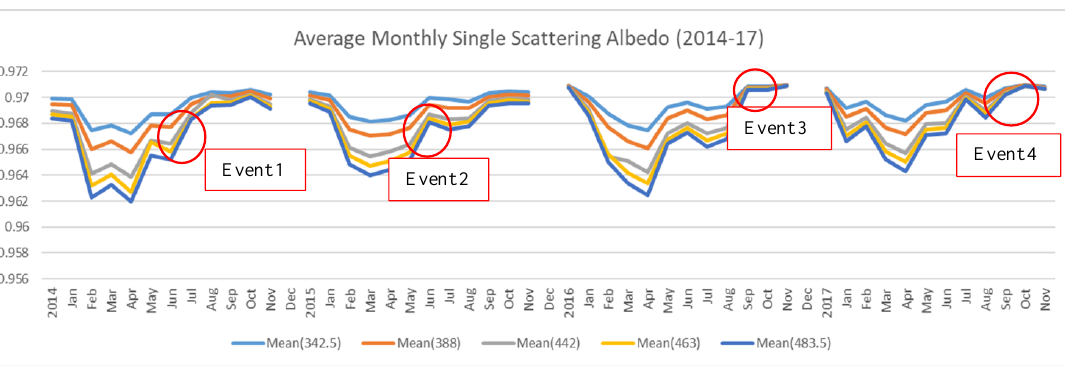
Figure 9: Average Single Scattering Albedo for